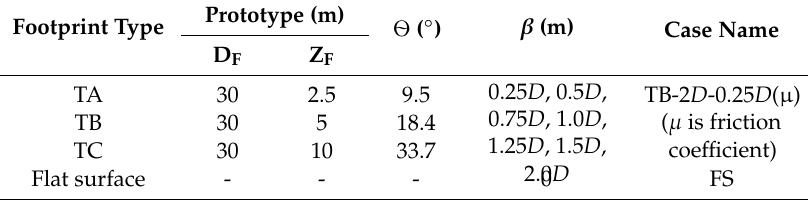
Figure 6. Dimensions of three types of footprint. Table 1. Numerical cases.